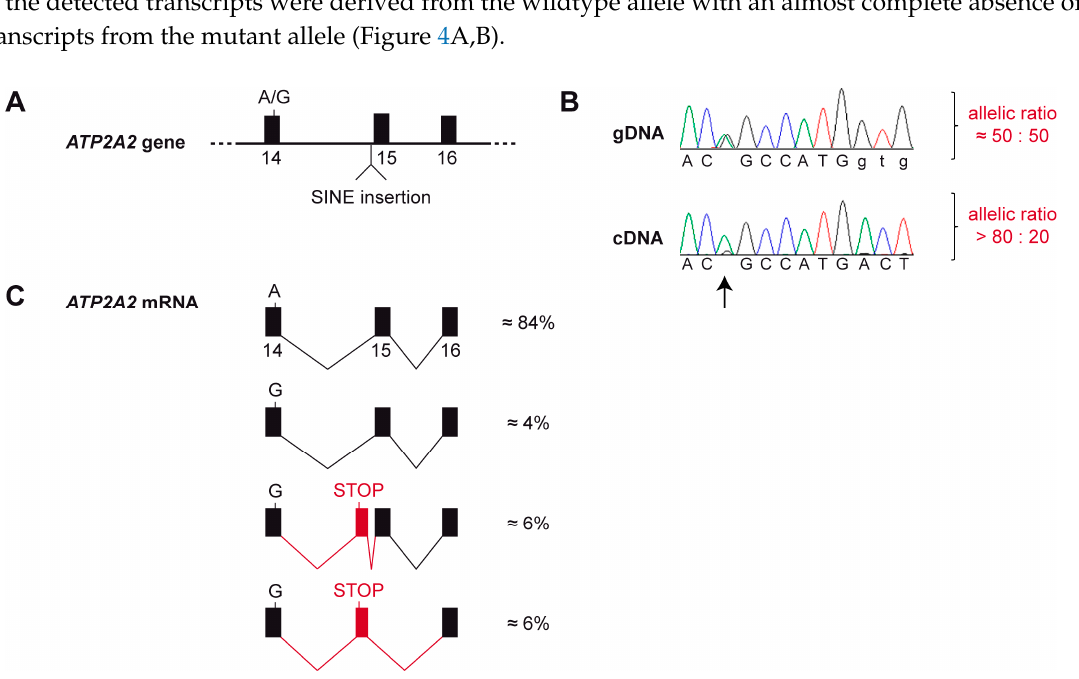
Figure 4. Splicing defect and allele-specific expression of the ATP2A2 mRNA. ( A ) Genomic organization of the ATP2A2 gene. The affected dog was heterozygous at the silent c.2091A>G variant located at the end of exon 14 and heterozygous for the SINE insertion in intron 14. ( B ) A Sanger electropherogram obtained from a genomic PCR product shows the expected equal ratio of the two alleles at c.2091A>G. In contrast, a Sanger electropherogram obtained with the same sequencing primer from a cDNA amplicon showed a strong bias towards the A-allele (arrow). This semi-quantitative analysis suggests that the transcripts from the mutant ATP2A2 allele are degraded, possibly by nonsense mediated decay or another mechanism of the cellular quality control. ( C ) RNA-seq analysis from skin of the affected dog confirmed the strong allelic bias in the transcripts. Only very little functional transcripts are produced from the G-allele. The majority of the transcripts from the G-allele contain an aberrant exon and a premature stop codon. Further details of the RNA-seq analysis are shown in Figure S1.